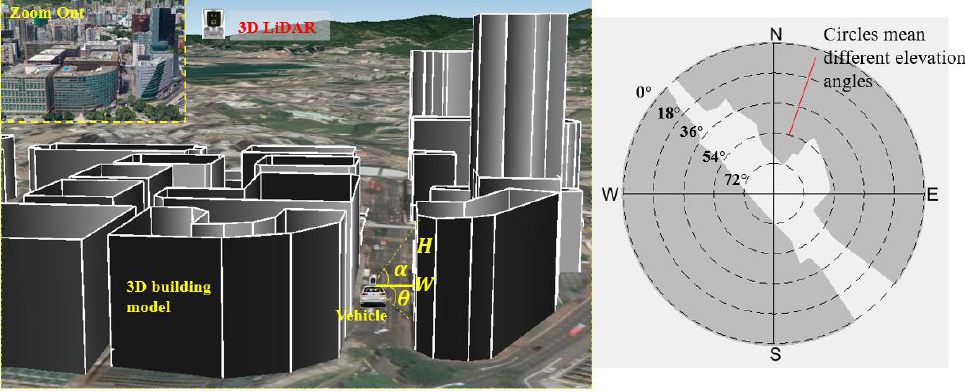
Figure 3. Skyplot generation based on 3D building models. 244